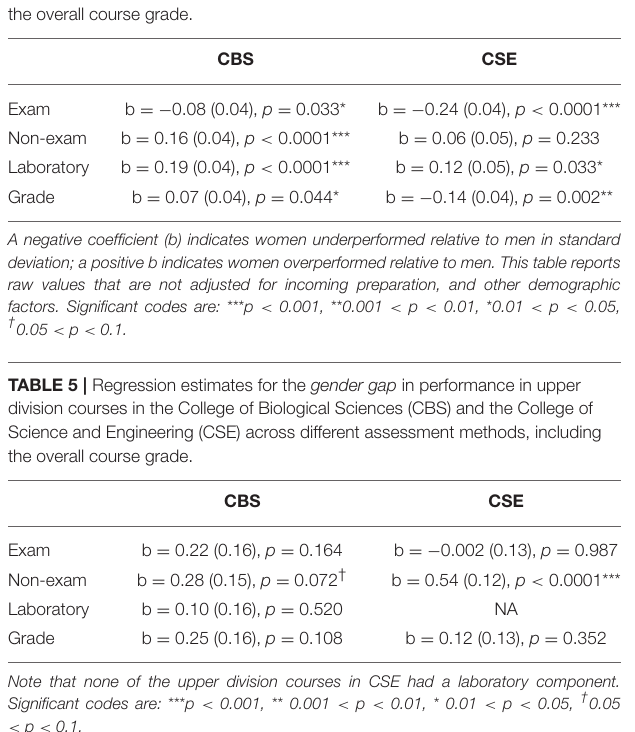
TABLE 6 | The simplest best fitting models predicting performance in lower division courses across different assessment methods in the College of Biological Sciences (CBS) and the College of Science and Engineering